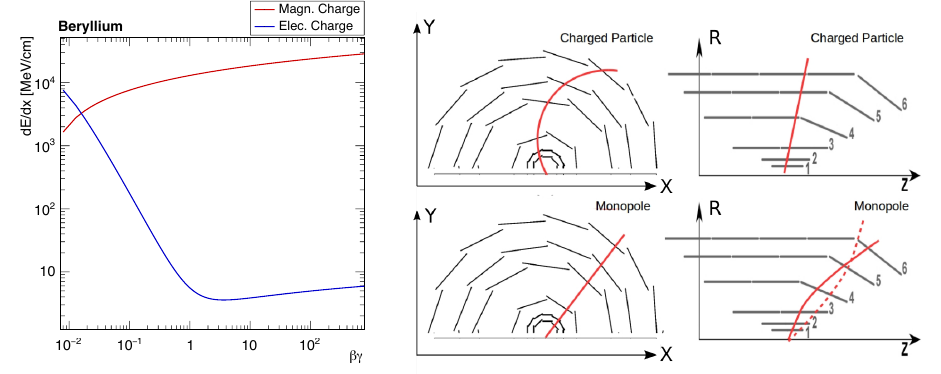
Figure 1: Energy loss in Beryllium and trajectory of particles with magnetic and electric unit charge. The description of energy loss for magnetic monopoles requires a modification of the Bethe-Bloch curve resulting in an energy loss, which is approximately four orders of magnitude higher compared to electrically charged particles with the same mass. The trajectories of magnetically charged particles in a magnetic field parallel to the z axis di ff ers from the trajectory of electrically charged particles in the same field configuration.